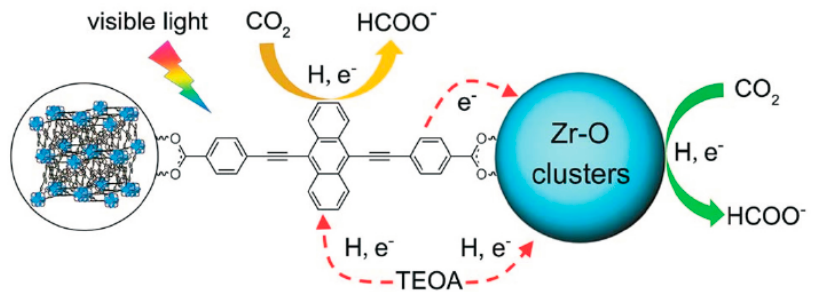
Figure 2. Two catalytic pathways for the reduction of CO 2 to formate. Reprinted from ref. 78 with permission by the Royal Society of Chemistry.